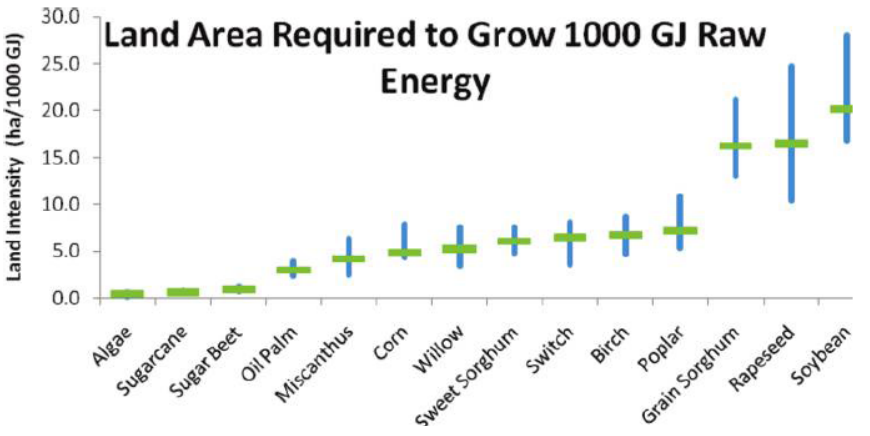
Land use intensity per 1000 GJ produced for different bioenergy feedstock sources